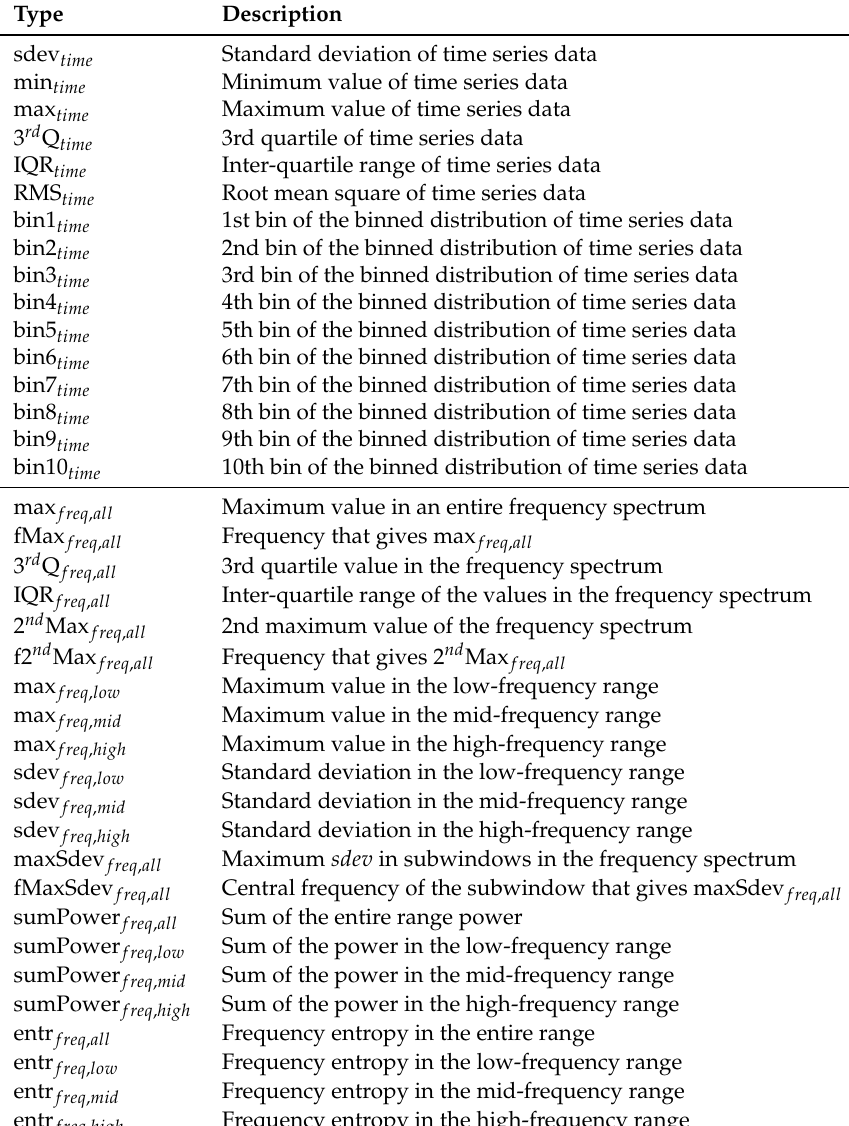
Table 3. Classification features ( x -, y - and z -axes and the magnitude ( m ) of the three